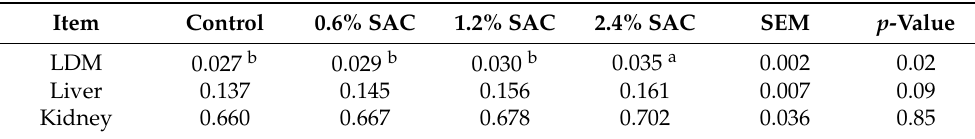
Table 10. Effects of dietary Selenium Auricularia cornea culture supplementation on tissue Selenium concentrations